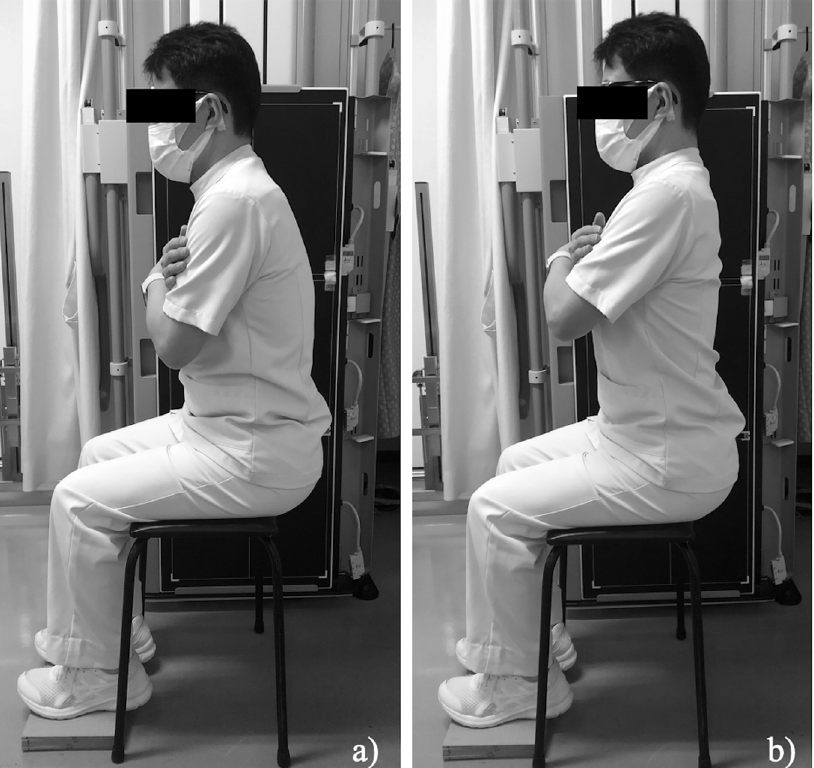
Figure 2. Seating positions. The patients sat back properly on the stool with their thighs parallel to the fl oor and their knees bent at right angles with their feet just on the boards, and follow two explicit instructions: (a) “ relax and round their back ” (relaxed seated position); and (b) “ straighten up their back ” (straight seated